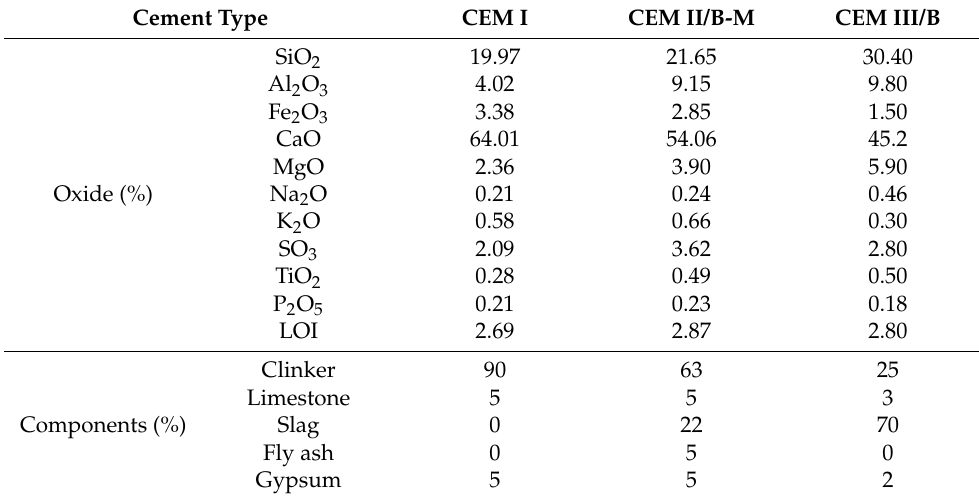
Table 1. The composition of different microfine cements in this study.